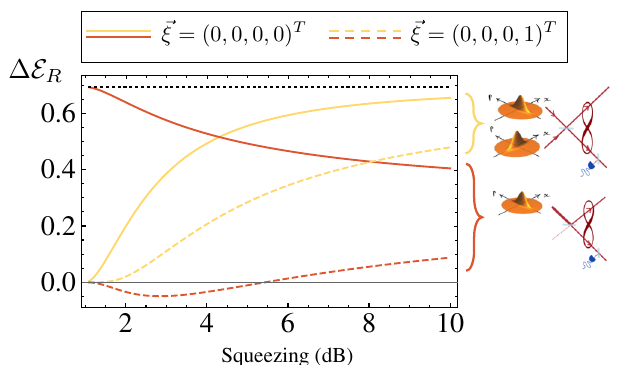
FIG. 6. Entanglement increase, Eq. (266), through photon sub- traction in one mode of a pair of entangled modes. The ini- tial Gaussian states are obtained by mixing either two equally squeezed modes (yellow curves) or one squeezed mode and one vacuum mode (red curves) on a beam splitter (see also sketches on the right). We show how a variation of squeezing (in dB com- pared to shot noise level) in these initial squeezed vacuum states influences the entanglement increase due to photon subtraction. mean field (cid:13) ξ = ( 0, 0, 0, 1 ) T (dashed